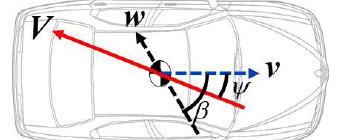
Figure 3. Vehicle speed 𝒗 , true wind speed 𝒘 , and apparent wind speed 𝑽.